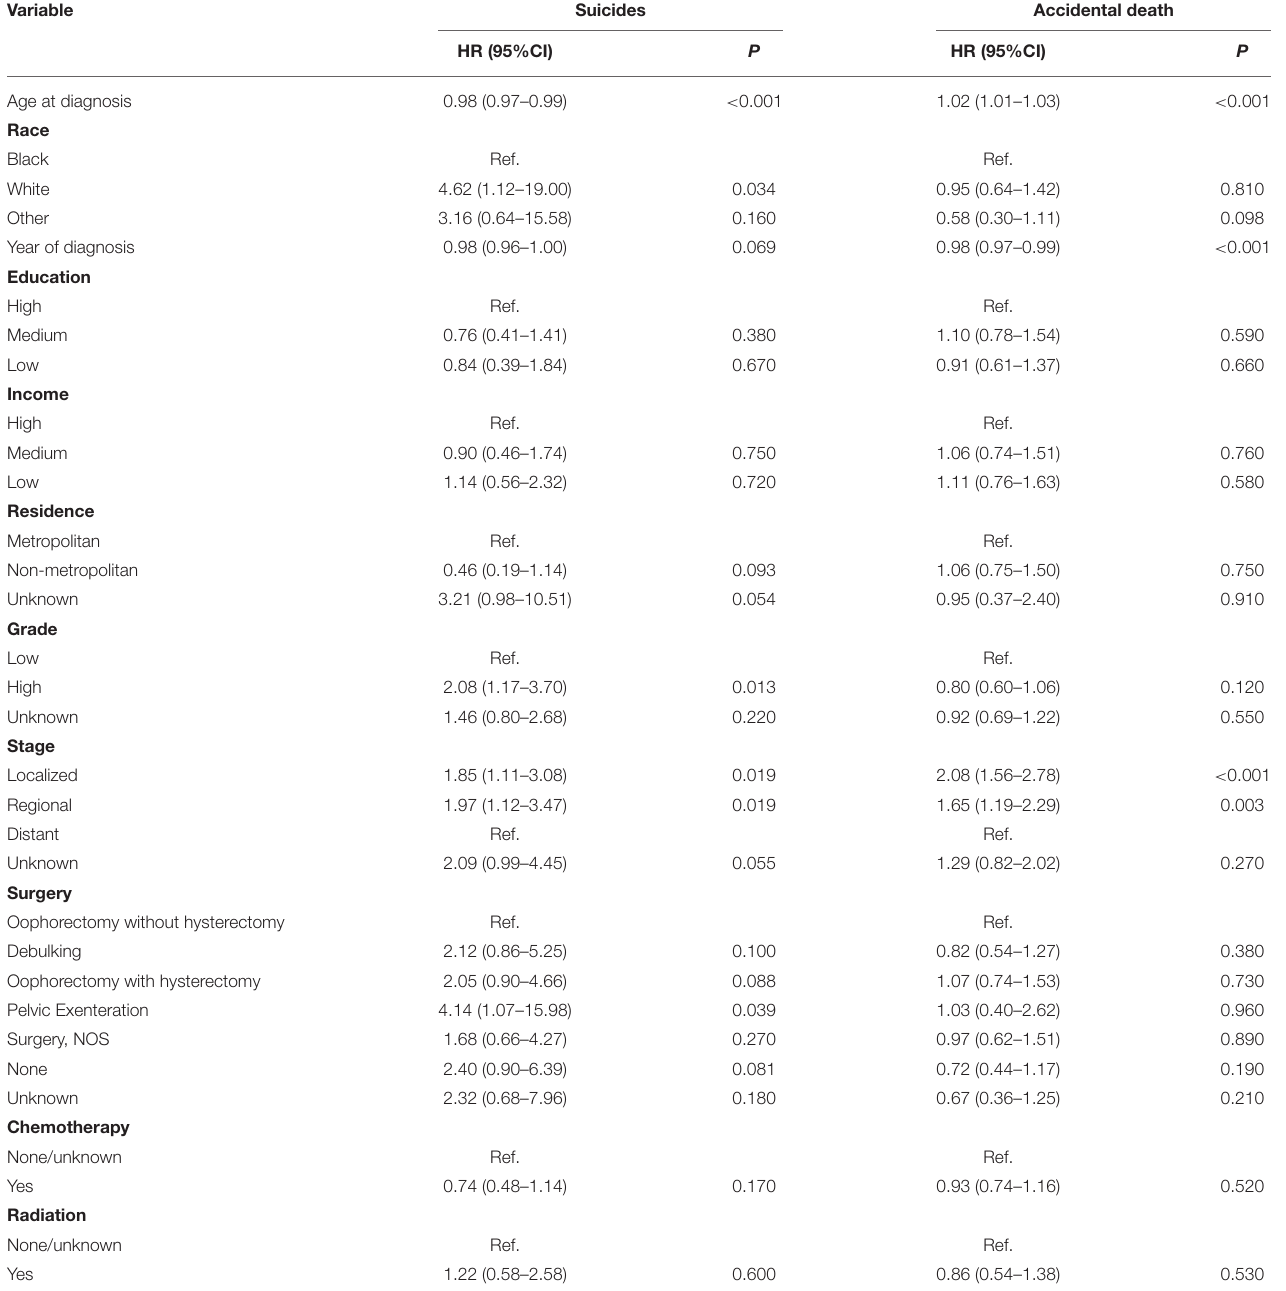
TABLE 4 | Fine and Gray model for the risk of suicide and accidental death among patients with ovarian